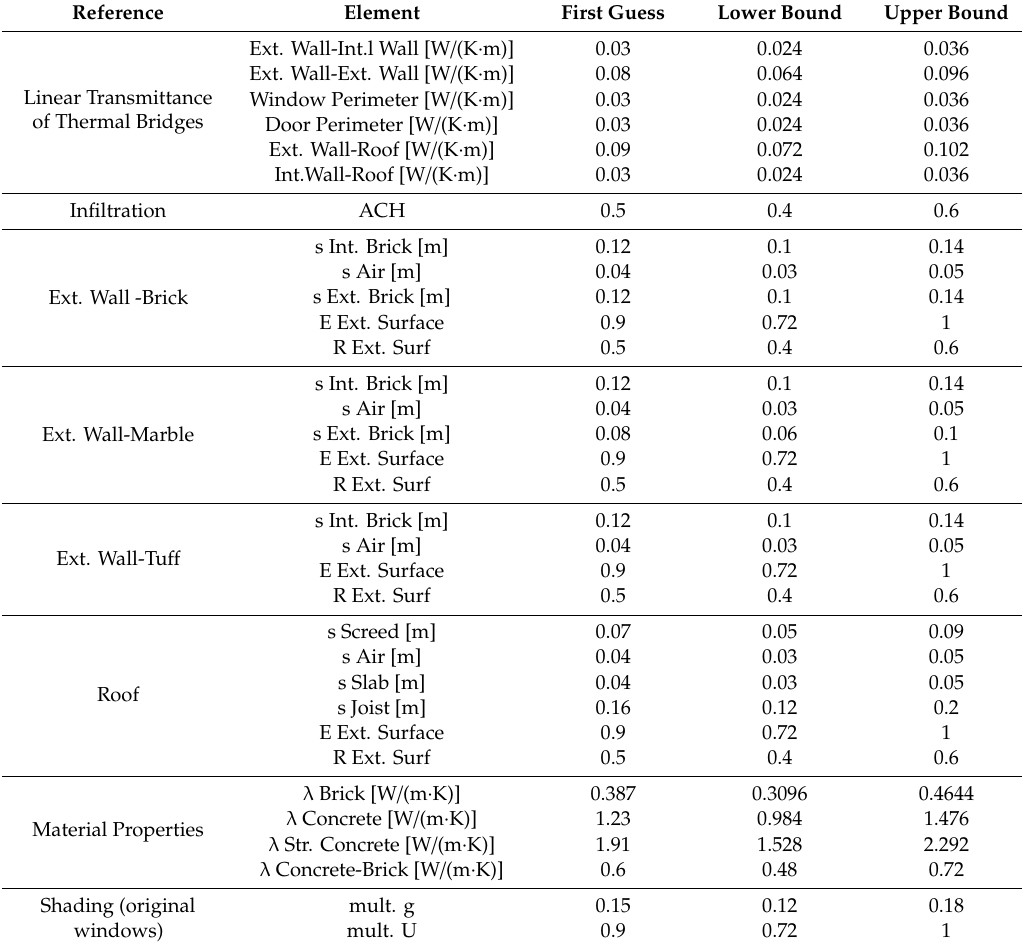
Table 9. Parameters collection for Sensitivity Analysis A *.